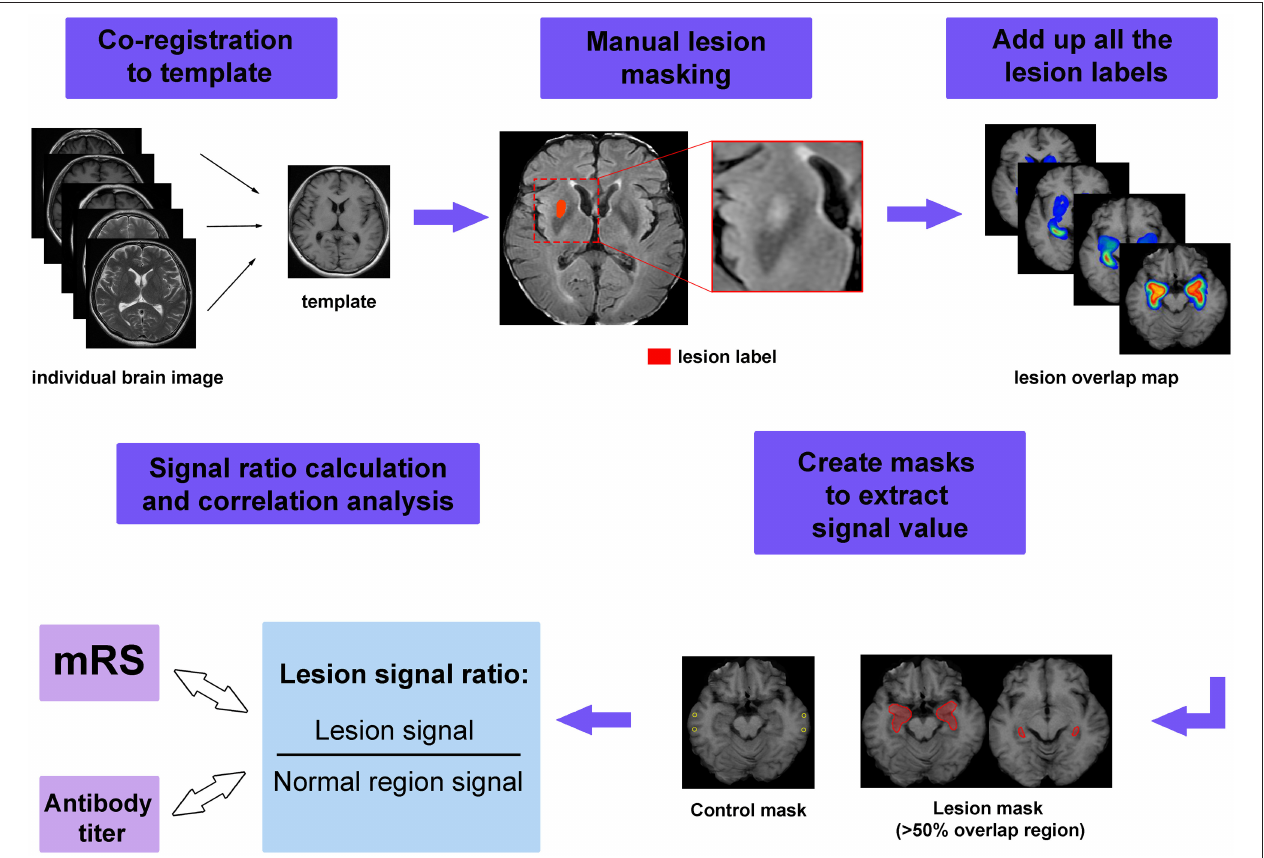
FIGURE 1 | The workflow of image processing. First, the individual image was coregistered to the template and manual lesion masking was performed on the registered image. Next, all lesion labels were added together to form the lesion overlap map. Masks were created to extract the signal value, in which lesion masks were created by applying a threshold of 50% to the overlap map, while control masks were chosen from normal appearing region. Finally, the signal ratios were calculated and used to perform the correlations with modified Rankin Scale (mRS) scores and serum antibody